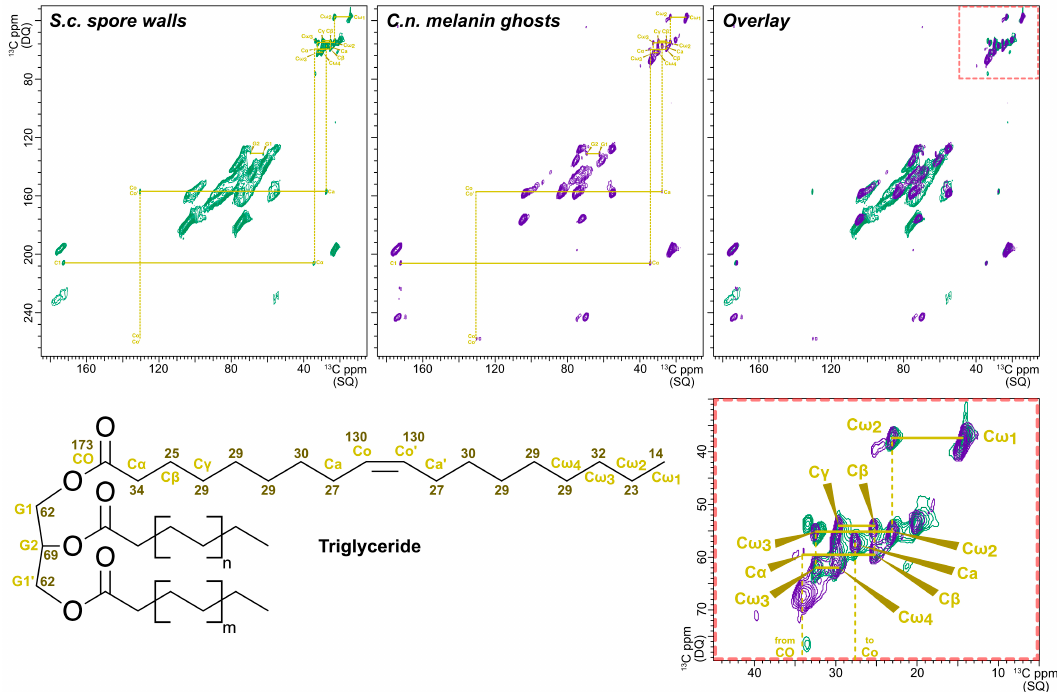
Figure 3. 2D 13 C- 13 C J-INADEQUATE ssNMR spectral comparison of outer spore walls isolated from wild type (AN120) S. cerevisiae cells (green spectrum) and melanin ghosts isolated from wild type (H99) C. neoformans cells (purple spectrum), both grown in media containing 13 C-enriched glucose as the sole carbon source. The displayed signals are attributable to pairs of carbons separated by one covalent bond. The cross-peaks corresponding to the connectivities within triglycerides have been annotated with wedges. The box at the lower right shows an expanded region of the overlay (red dashed lines). The numbers on the structure at the bottom left indicate the expected chemical shift for each carbon.